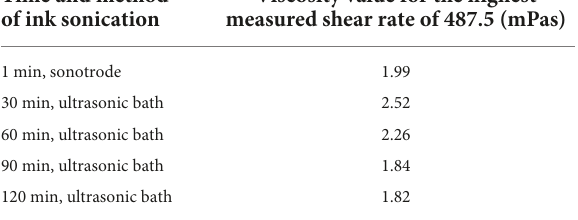
TABLE 2 Viscosity values for a shear rate of 487.5 mPas for graphene inks sonicated for 30, 60, 90, and 120 min using an ultrasonic bath and 1 min using a